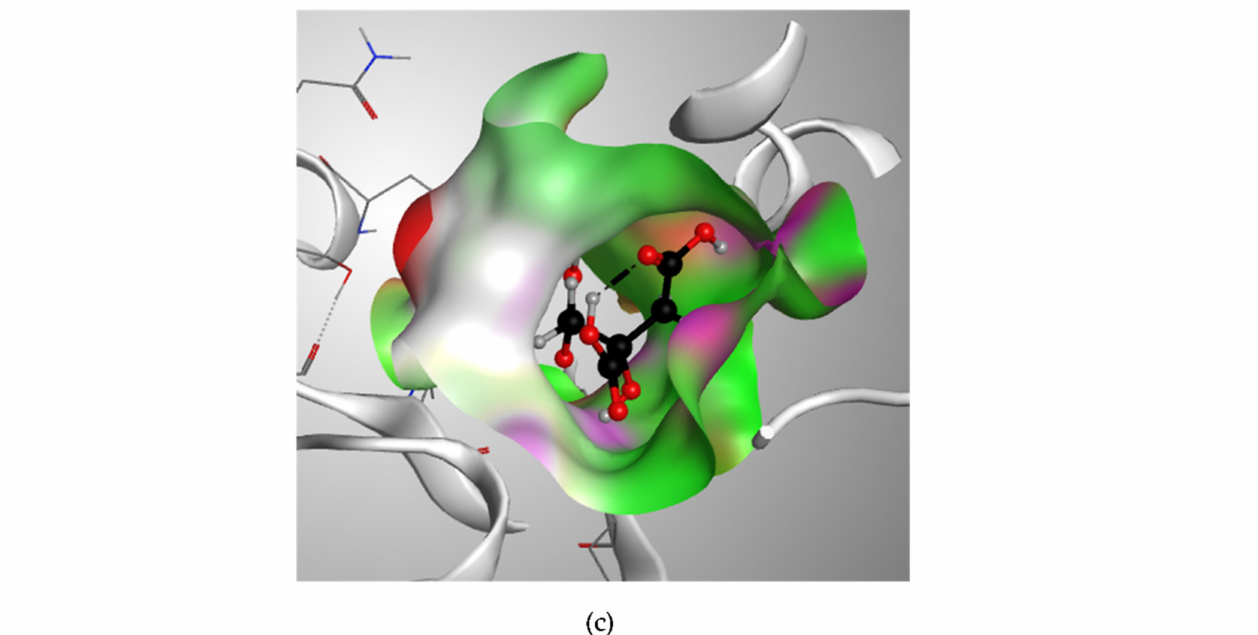
Figure 4. The molecular docking study of glutamine synthetase with the co-crystalized ligand adeno- sine diphosphate (ADP) and the candidate ligand citric acid: ( a ) Two-dimensional interactions of the co-crystalized ligand ADP within the glutamine synthetase active site; ( b ) Two-dimensional interac- tions of citric acid within the glutamine synthetase active site; ( c ) Three-dimensional interactions of citric acid within the glutamine synthetase active site. Table 1. Summary of the docking results of the binding of candidate ligands Citric acid, Malonic acid and D-tartaric acid to target proteins Glutamine Synthetase, Aspartate 1-Decarboxylase